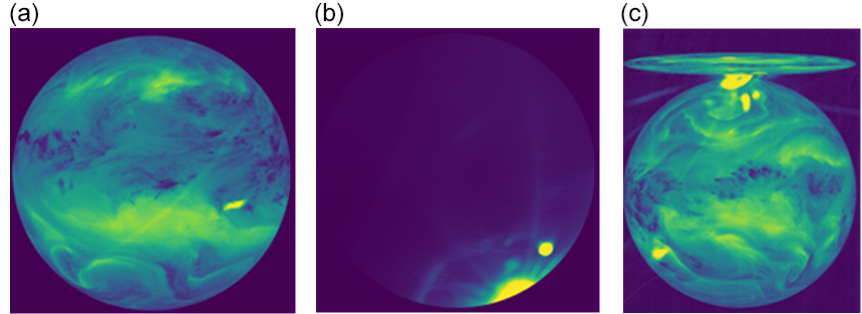
Figure 7. Three examples of the direct stray-light effect anomaly. (a) Taken from file METEOSAT7-MVIRI-MTP15-NA-NA- 20130717210000 and channel WV. (b) Taken from file METEOSAT7-MVIRI-MTP15-NA-NA-19991016003000 and channel VIS. (c) Taken from file METEOSAT4-MVIRI-MTP10-NA-NA-19900415003000 and channel WV. The pixel values are the raw digital counts (see also Fig. 2; ©EUMETSAT).